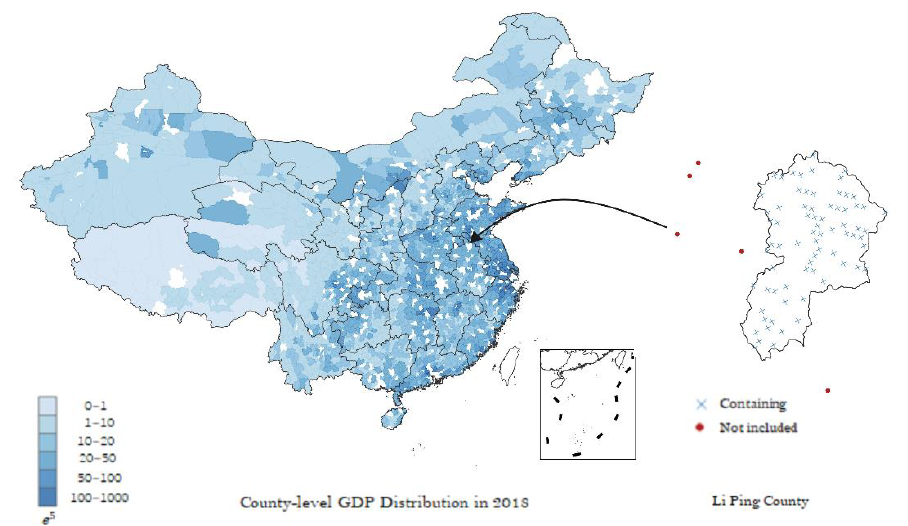
Figure 3. The GDP distribution map of the Chinese Mainland in 2018 (some values along with the boundaries of county-level units are missing), and an example of matching center coordinates and county boundaries. Blue crosses denote center coordinates that fall into the boundary of Liping County, while red points denote centers that do